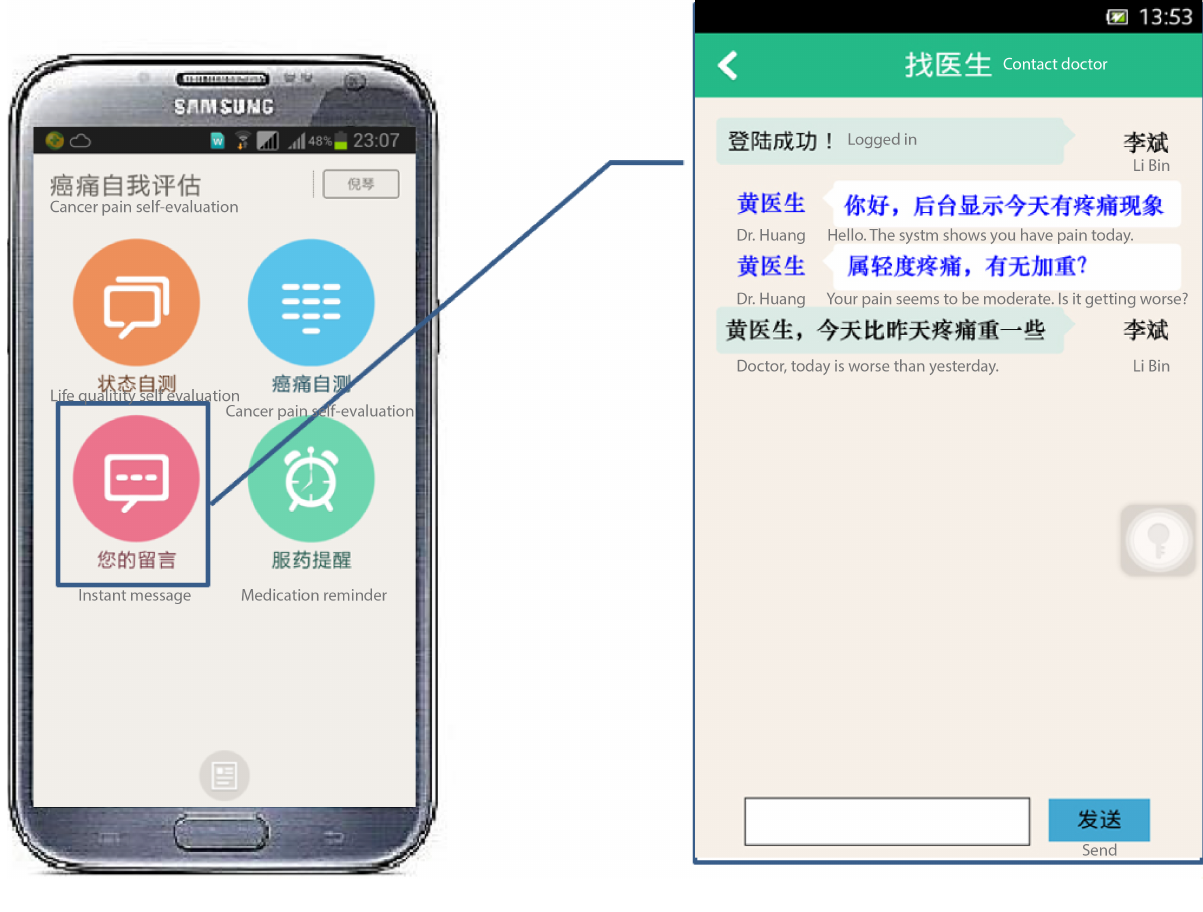
Figure 6. Screenshots of real-time message (left) and example (right).